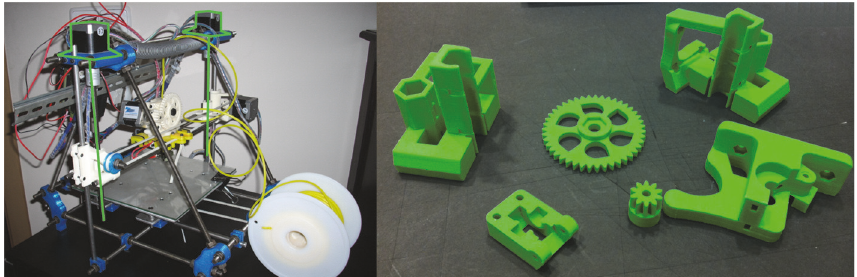
Figure 10: Example of RepRap machines and parts for